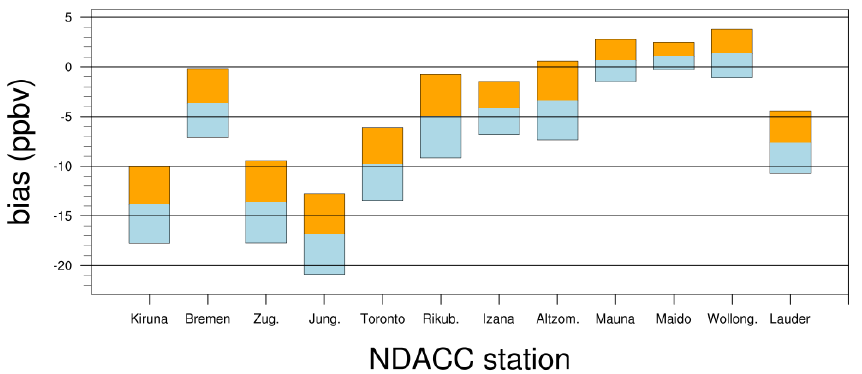
Figure 6. Biases between SOFRID and FTIR monthly MT N 2 O VMRs at the 12 NDACC stations averaged over the 2008–2018 period. The orange and lightblue bars represent the corresponding Root Mean Squares of the Differences.